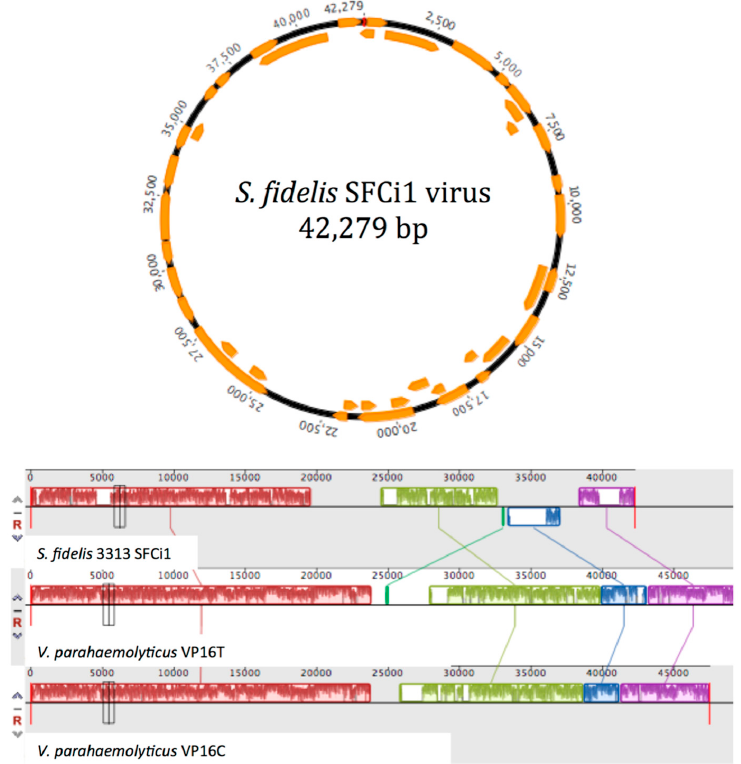
Figure 3. ( A ) Circular genome of lytic phage SFCi1 depicts 40 open reading frames (ORFs). ( B ) Mauve alignment of the SFCi1 genome against two most closely related phage genomes, VP16C and VP16T. Colored boxes indicate sequence blocks with shared sequence identity; regions lacking sequence homology are indicated in white.